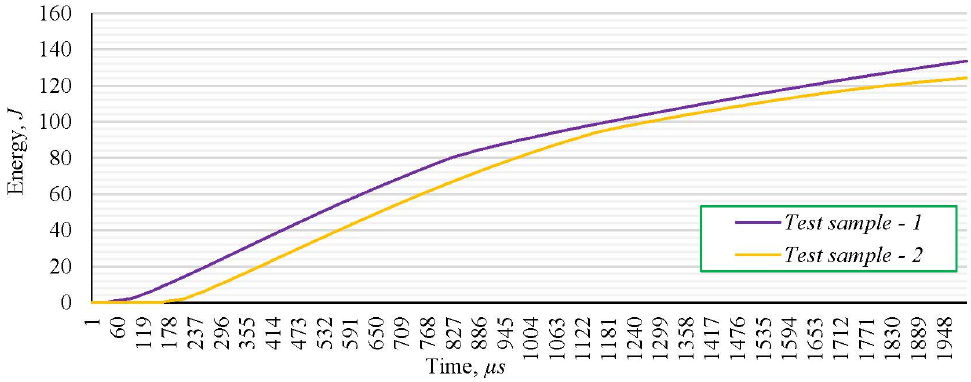
Figure 5. Flow of energy during the impact toughness test of the S690 samples.